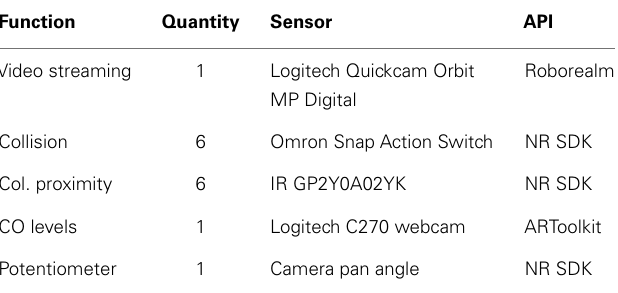
Table 5 | Study #4 robot sensors, their quantity, function, andAPIs .